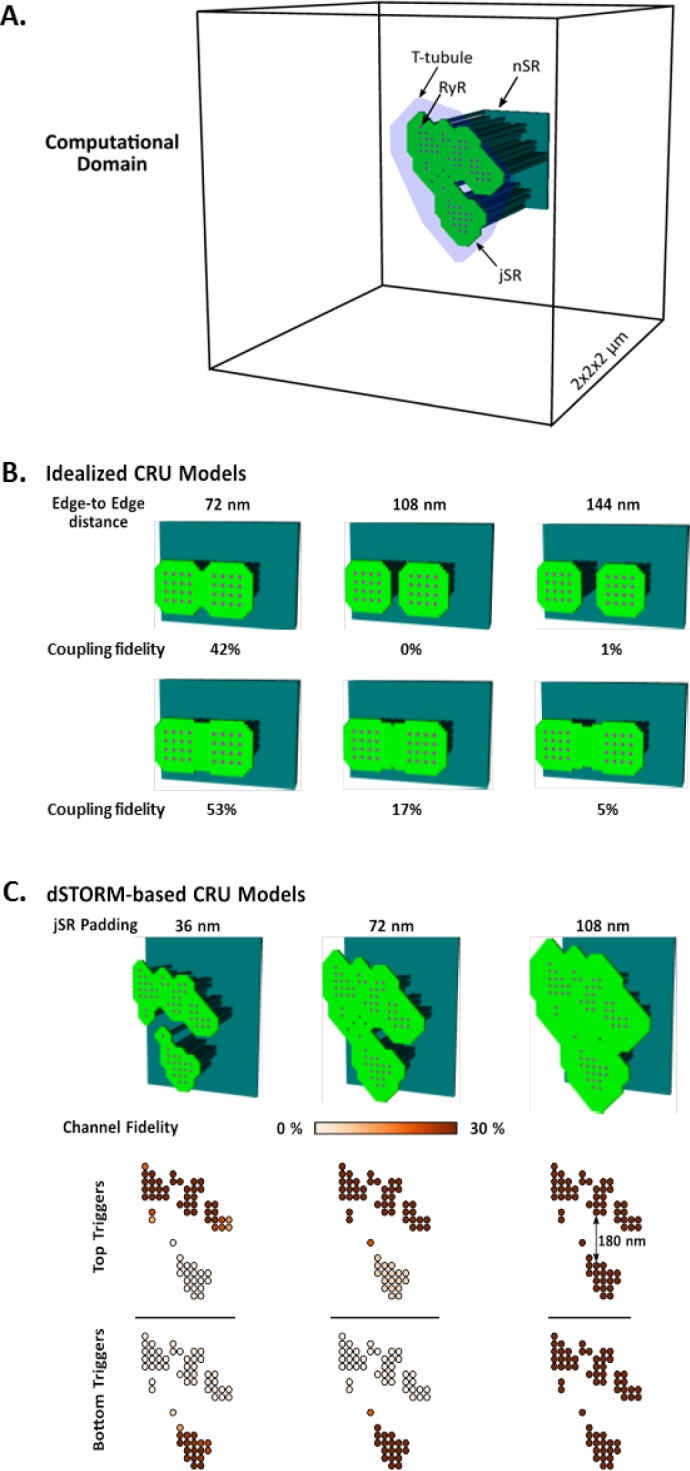
Development and characterization of the mathematical dyadic model.(A) Graphical representation of the computational domain of the model. The junctional SR (jSR) was shaped to encompass idealized RyR geometries or dSTORM-based CRU contours. (B) To understand the role of the jSR geometry in determining the maximum inter-cluster distance permissive of functional coupling, and thus CRU definition, we spread two square 16-RyR clusters at variable distances up to 144 nm edge-to-edge (i.e. 4 RyR lengths). Coupling could occur at distances up to ~ 150 nm but only when the jSR was contiguous between clusters. (C) Similar effects could be observed in the realistic 7-cluster geometry, where a fully contiguous jSR was sufficient to functionally couple clusters at distances between 100 and 150 nm.